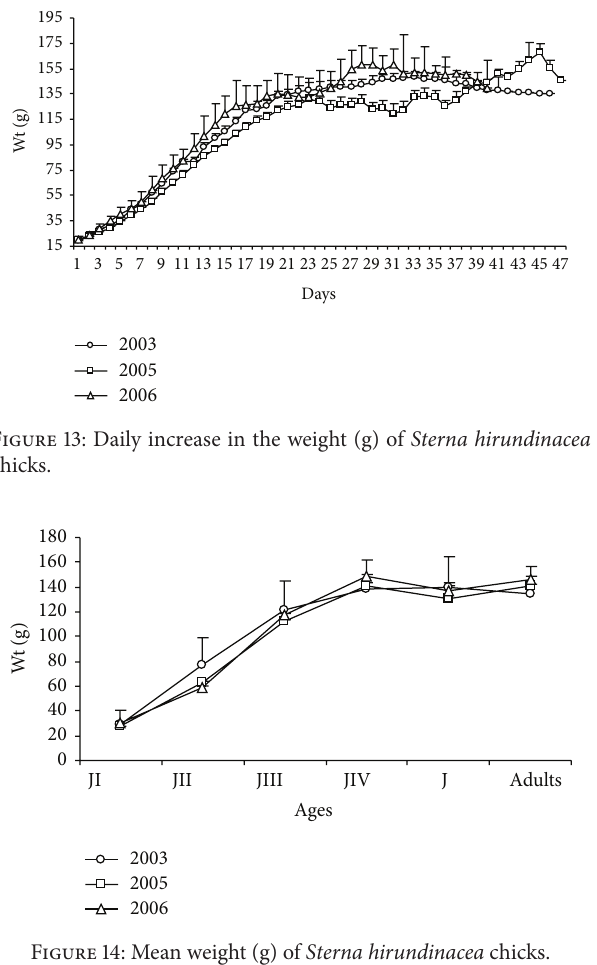
Figure 14: Mean weight (g) of Sterna hirundinacea chicks.